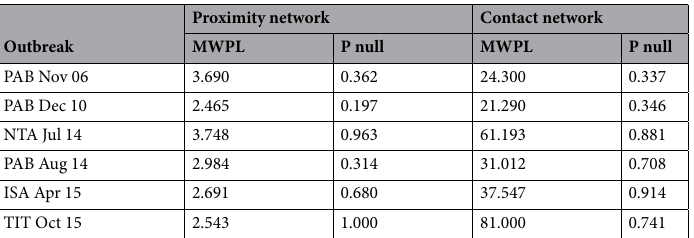
Table 2. Analysis of respiratory disease transmission during outbreaks (group code, month and year) between 2004 and 2015, excluding those where signs of infection were observed in every group member. Mean weighted path length (MWPL) calculated between all group members to show signs of infection during an outbreak. P null is the proportion of null models for which the mean weighted path length between individuals showing signs of infection was shorter than that observed in the real outbreak. For network diagrams of the distribution of signs across each network see Fig. 2.